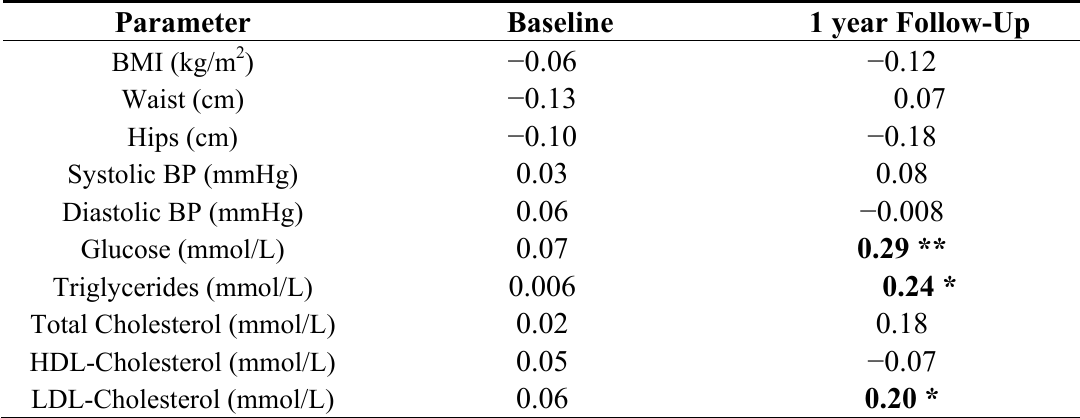
Table 3. Spearman’s Correlation between Serum Cortisol (nmol/L) with Cardiometabolic Parameters according to